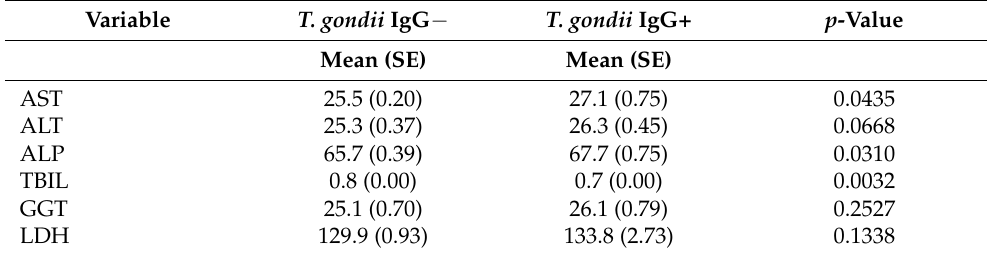
Table 2. Means (standard error) of liver injury biomarkers by T. gondii exposure status (IgG+/IgG − ).